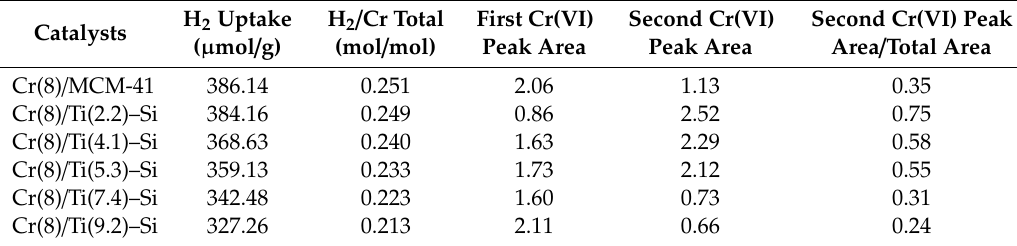
Figure 6. H 2 –TPR profiles spectra of Cr(8)/MCM ‐ 41 and Cr(8)/Ti(x)–Si ‐ nanocomposite catalysts prepared with varying titanium content wt %. Table 3. Reducibility data obtained from H 2 –TPR profiles of Cr(8) / MCM-41 and Cr(8) / Ti(x)–Si